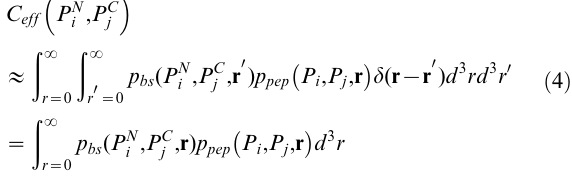
PLoS Computational Biology |